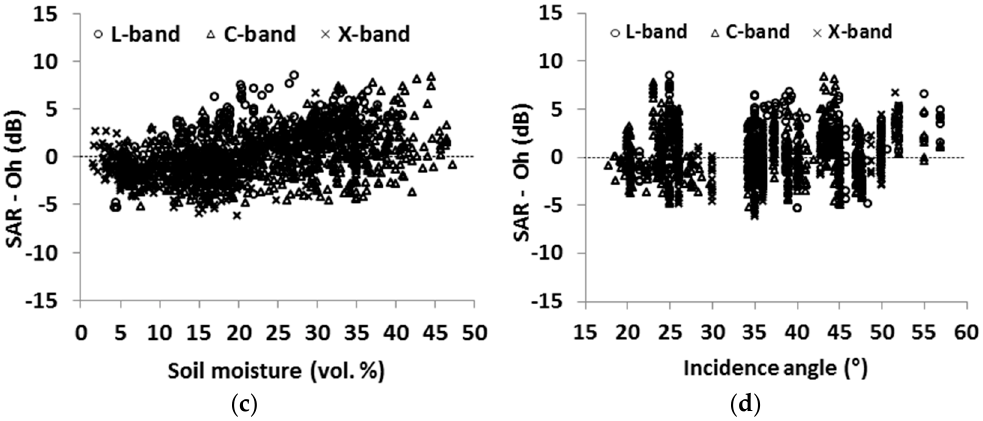
Figure 3. Comparison between backscattering coefficients derived from SAR images and those estimated from the Oh 1992 model at HH polarization, ( a ) Oh model simulations vs. SAR data; ( b ) difference between SAR signal and Oh model results vs. soil roughness ( kHrms ); ( c ) difference between SAR signal and Oh model results vs. soil moisture ( mv ); ( d ) difference between SAR signal and Oh model results vs. incidence angle.